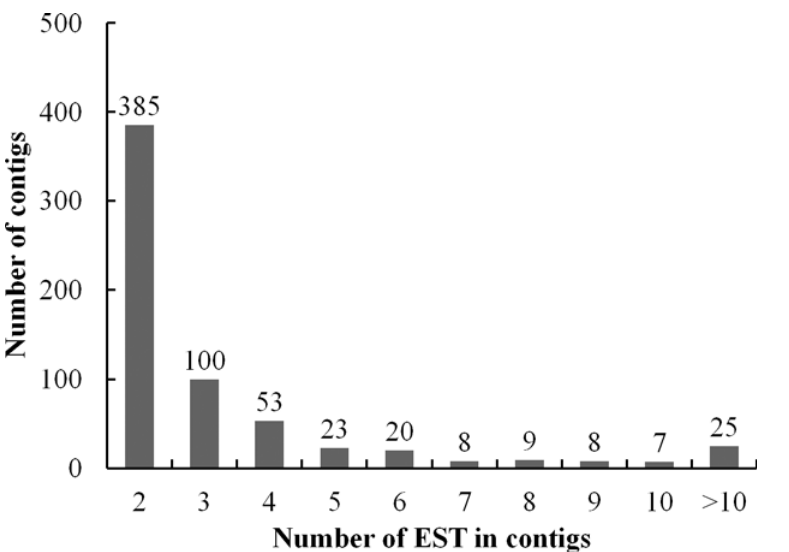
Fig 1. Distribution of 638 contigs based on the number of clustered